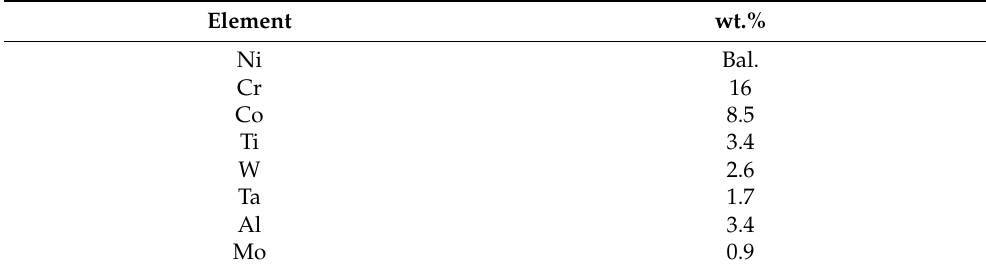
Table 1. Chemical composition of IN-738LC substrate used for applying aluminide coatings deter- mined by AAS method *.